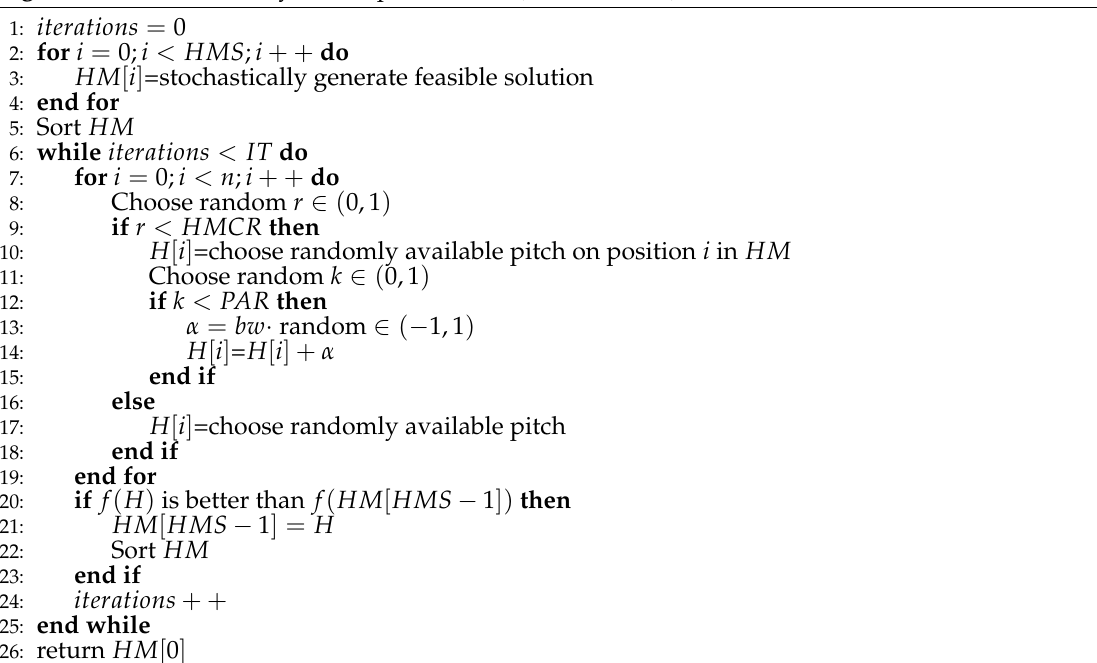
Algorithm 1 The Harmony Search pseudocode (based on